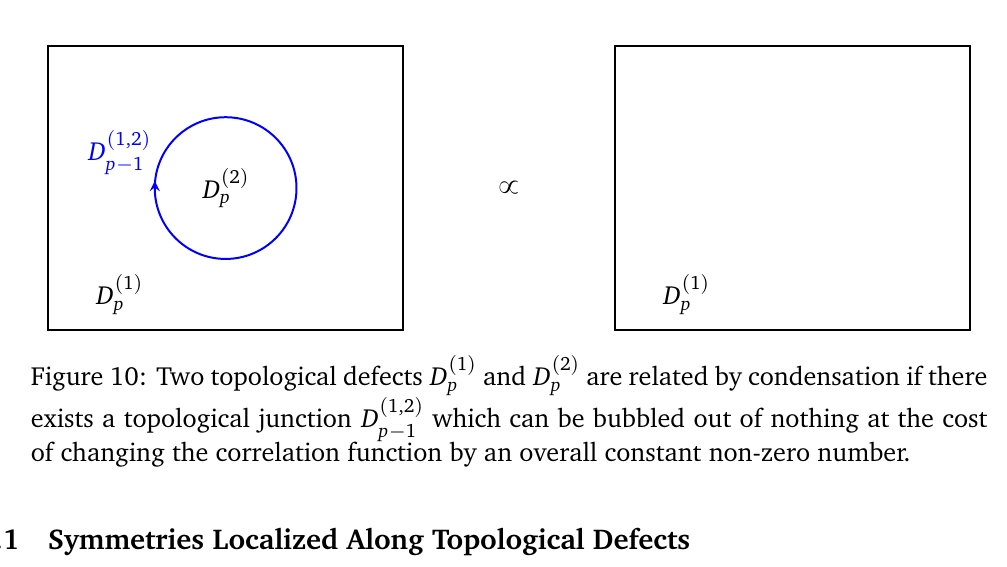
Figure 10: Two topological defects D p 1 q exists a topological junction D p 1,2 q of changing the correlation function by an overall constant non-zero